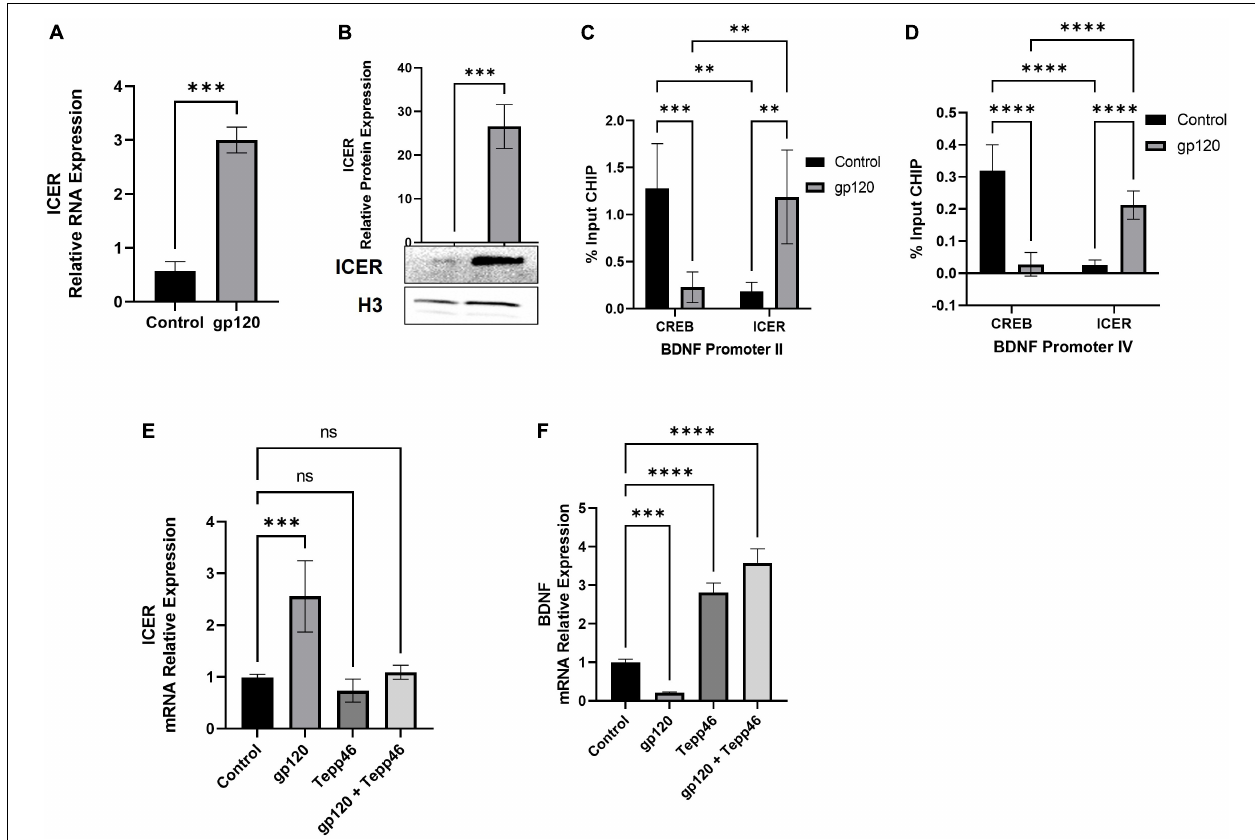
FIGURE 9 | Effect of gp120 on CREB/ICER signaling and HIF-1 α expression. (A) Expression of ICER mRNA isolated from untreated or HIV-1 gp120-treated LUHMES for 8 h as obtained by qPCR and normalized to GAPDH as an internal control. (B) Expression of ICER protein isolated from untreated or HIV-1 gp120-treated LUHMES for 8 h as obtained by western blot and normalized to H3 as an internal control. Quantification of the relative protein levels was determined from the band intensity using ImageJ software and normalized relative to the H3. (C,D) Interaction of ICER and CREB with BDNF promotors II (C) and IV (D) as obtained by ChIP in untreated and gp120-treated LUHMES cells. (E) Differentiated LUHMES cells untreated or treated with 100 ng/ml of gp120 and/or 10 nM of Tepp-46. Expression of ICER mRNA as obtained by qPCR and normalized to GAPDH. (F) Differentiated LUHMES cells untreated or treated with 100 ng/ml of gp120 and/or 10 nM of Tepp-46. The expression of BDNF mRNA is obtained by qPCR and normalized to GAPDH as an internal control Data represent the mean ± S.D. Results were judged statistically significant by ANOVA or students T -test ( ∗∗ p < 0.01, ∗∗∗ p < 0.001, ∗∗∗∗ p <